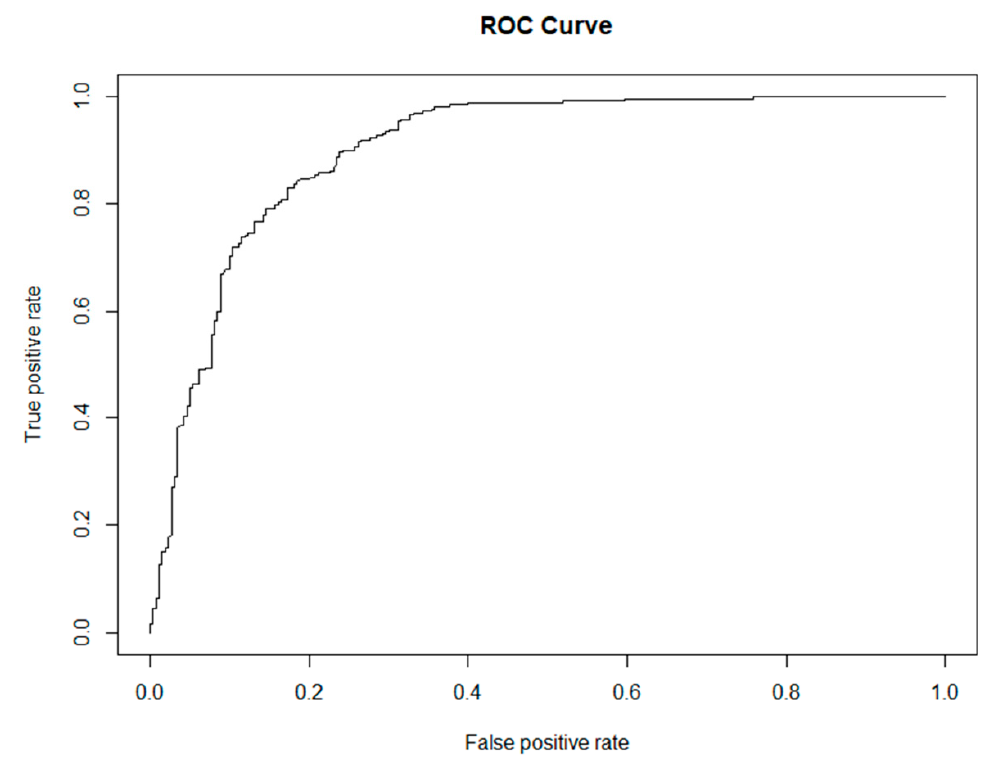
Figure 10. Receiver operating characteristic (ROC) curve computed from validation sample.